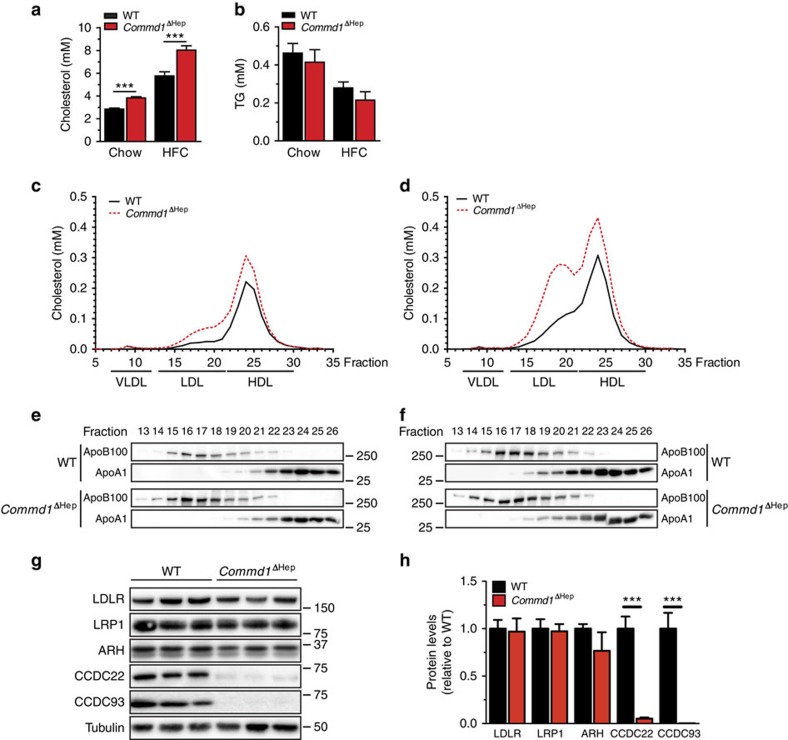
Ablation of hepatic Commd1 increases plasma total and LDL cholesterol levels.(a) Plasma TC and (b) TG levels of hepatic Commd1 knockout mice (Commd1ΔHep) and WT mice (n=6–8) fed a chow diet or a HFC (0.2%) diet for 20 weeks. Pooled plasma samples of each experimental group of mice fed either the (c) chow or (d) the HFC diet were separated using FPLC gel filtration. Fifty fractions were collected from each separation. TC content was determined and lipoprotein profile was plotted. Fractions #13–26 containing cholesterol were collected and loaded on an SDS polyacrylamide gel and blotted using antibodies against apoA1 and apoB100 lipoproteins. The chow group (e) and HFC group (f) are shown. (g) Livers of chow-fed mice were homogenized, and 30 μg of protein was subjected to immunoblot analysis. Levels of LDLR, LRP1, ARH, CCDC22, CCDC93 and tubulin were determined. Three representative samples from WT and Commd1ΔHep mice are shown. (h) Relative levels of the proteins shown in g were determined by immunoblot analysis, and densitometry analysis was performed using tubulin as a loading control (n=6–8 per genotype). The results are presented as mean±s.e.m., and significance was calculated relative to the control group by unpaired Student's t-test; ***P<0.001. ARH, autosomal recessive hypercholesterolaemia protein.